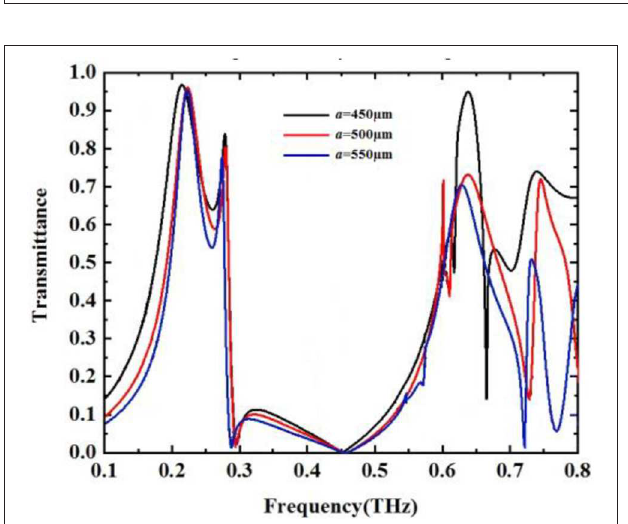
FIGURE 3 | Transmittance spectra of the proposed crossing fractal-air-crossing fractal structure for various values of t .